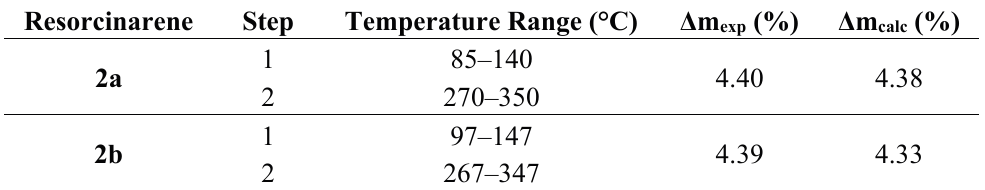
Table 1. Thermal behavior data for sulfonated